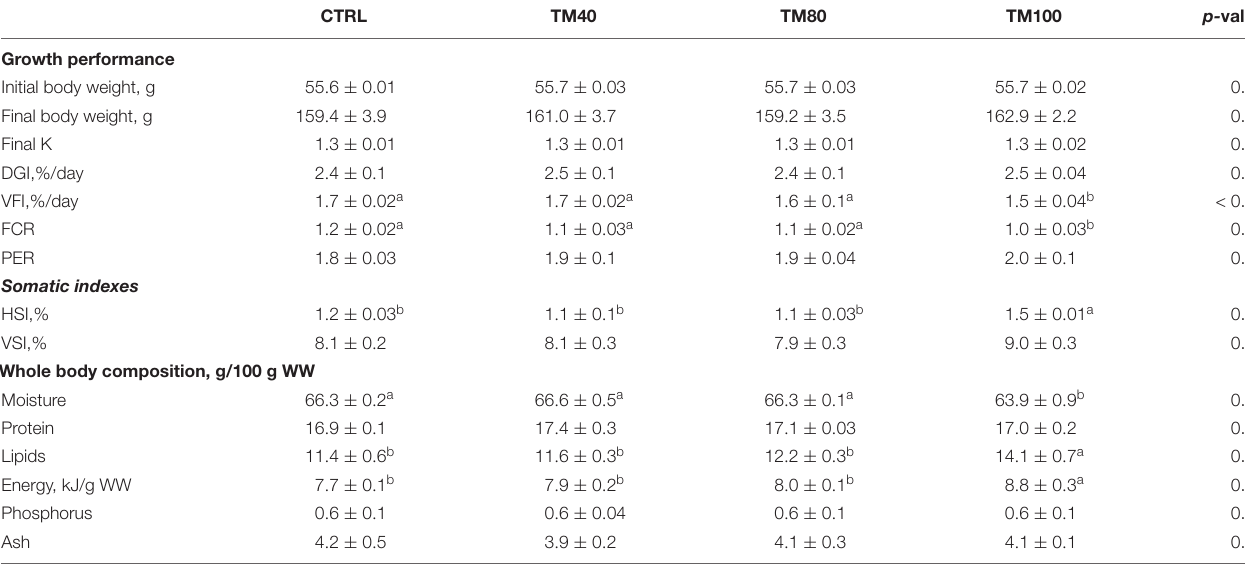
TABLE 5 | Growth performance, somatic indexes and whole-body composition of European sea bass fed experimental diets. CTRL TM40 TM80 TM100 p-